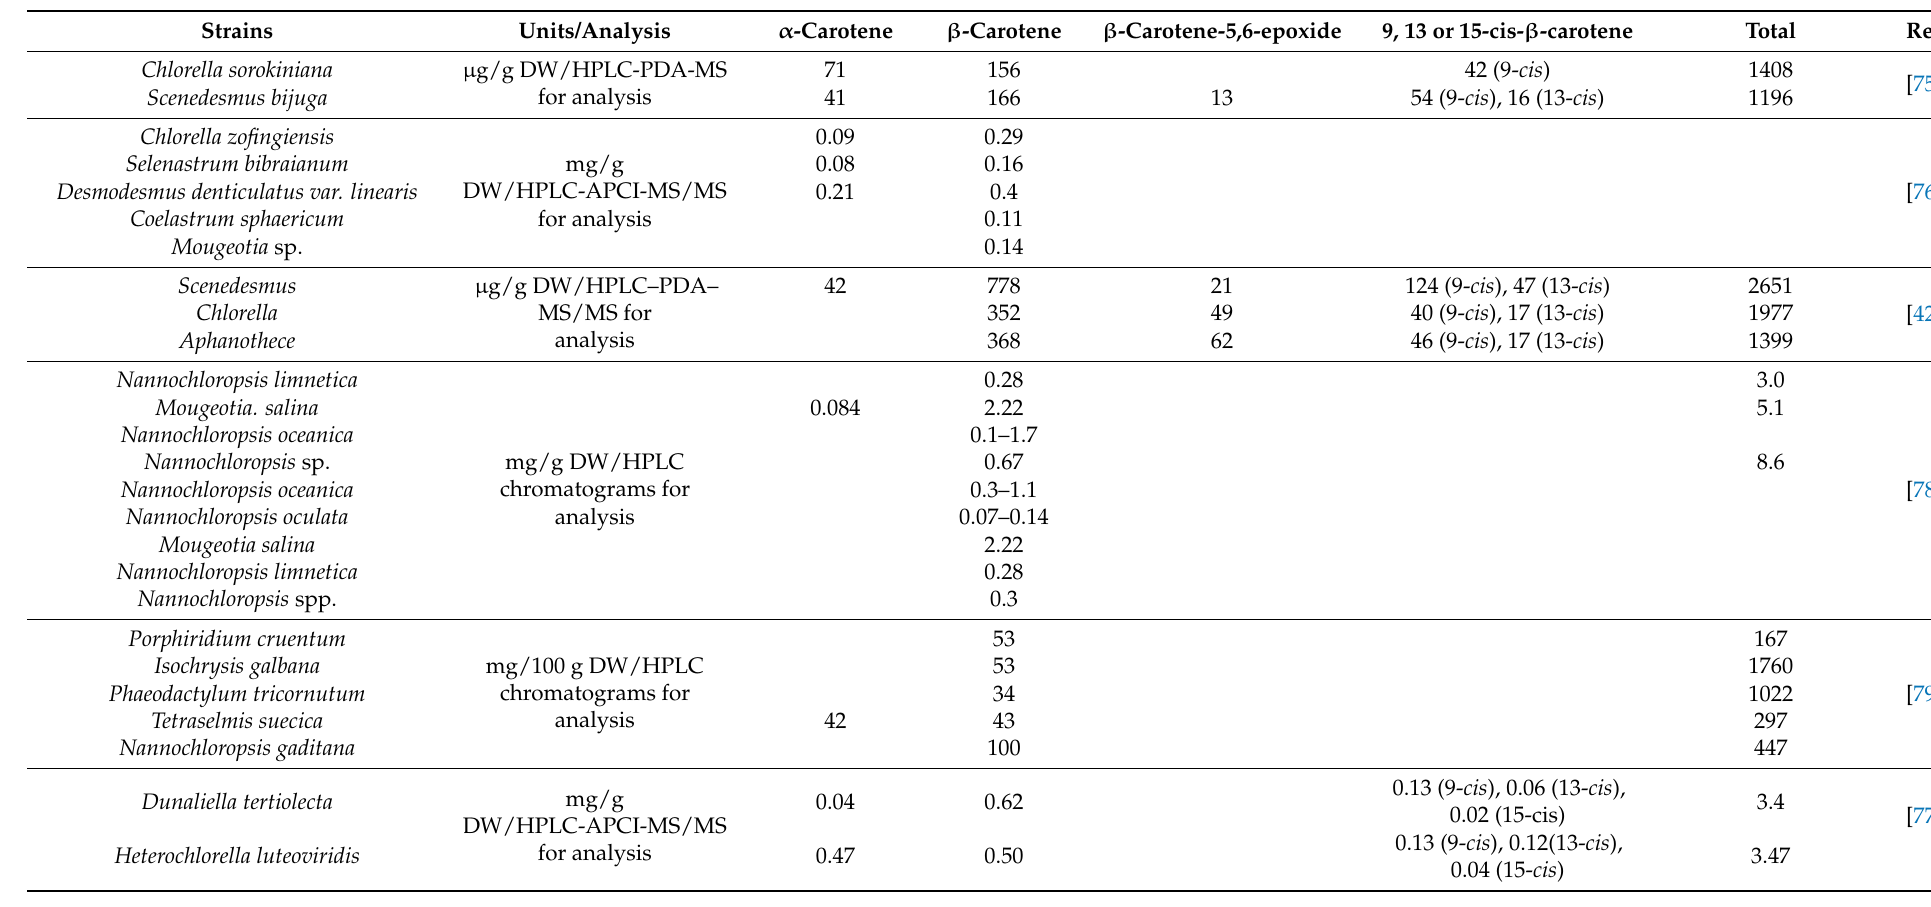
Table 1. Contents of α -carotene, β -carotene, β -carotene-5,6-epoxide, 9 or 13 or 15 -cis- β -carotene, and total carotenoids in different microalgae